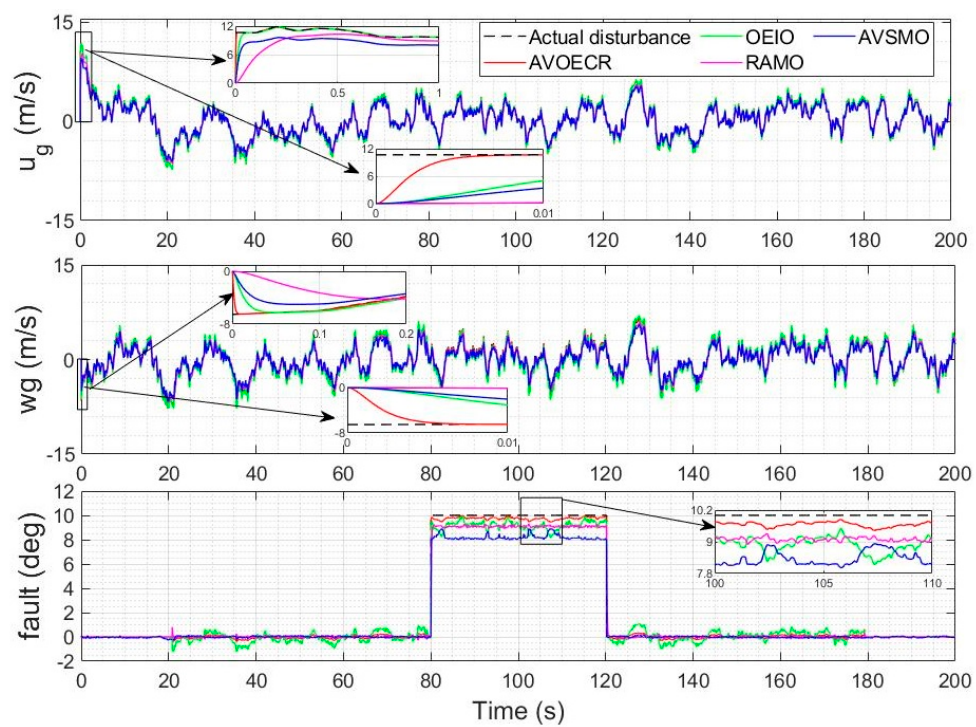
Figure 12. Actual and estimated wind velocities and actuator fault using observer-based compensa- tion with all observers (equivalent gains comparison).